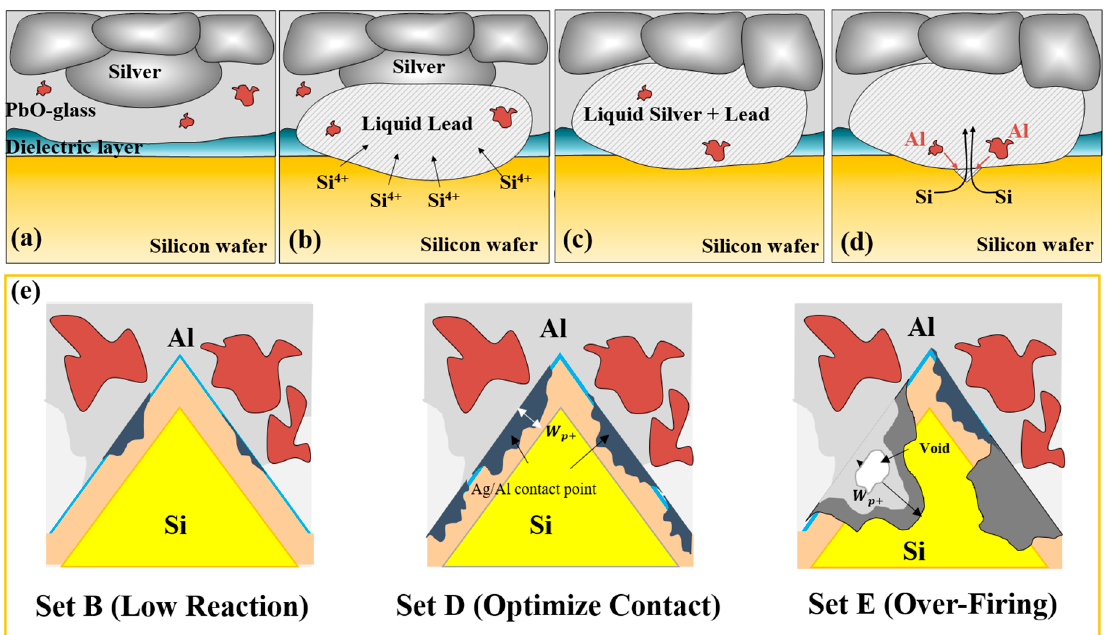
Figure 6. ( a – d ) Schematic of the reaction between the Ag–Al paste and the p+ diffused layer as the co- firing process progressed. ( e ) Surface reaction when firing temperature varied for sets B, D, and